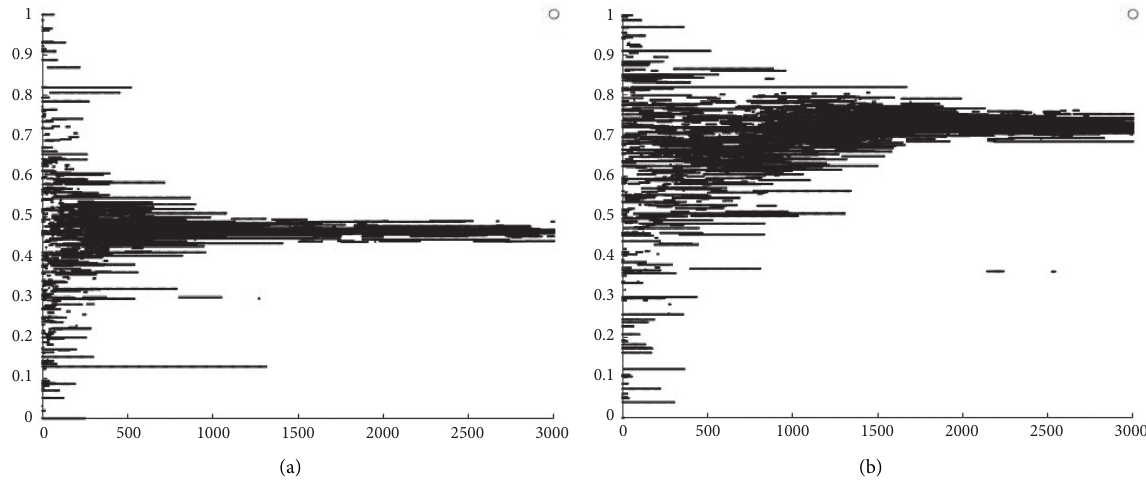
Figure 5: Group opinion evolution process in two